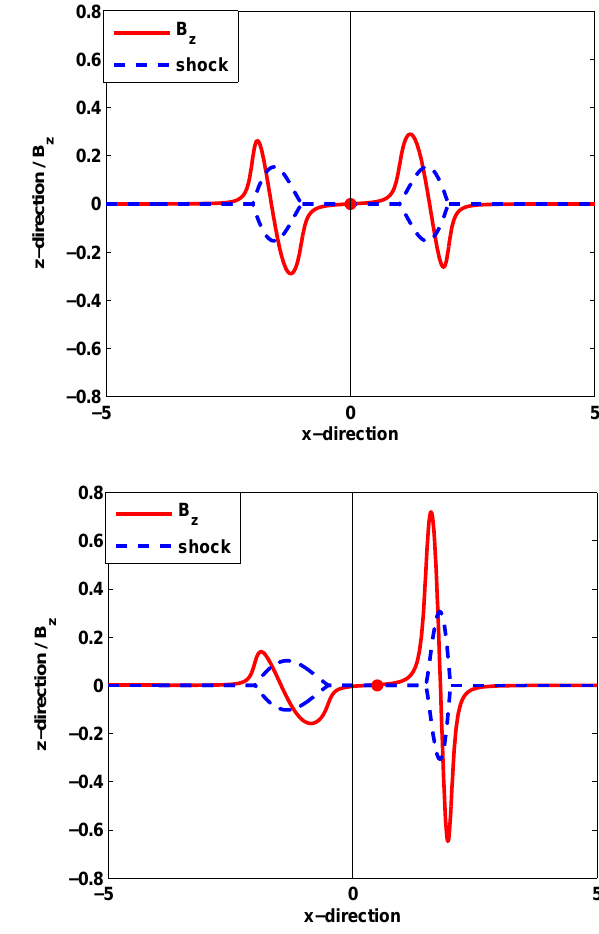
Fig. 9. Behavior of the magnetic field z-component in the inflow region. In the upper panel, the assumption U = 0 holds, whereas in the lower panel, the case U = 0 . 5 v A is shown. Both functions are calculated for t = 2. The change in the magnetic field strength as well as the actual positions of the field reversal regions are shown. The dot represents the final position of the reconnection line again. B z is blown up by the factor 10 for a better